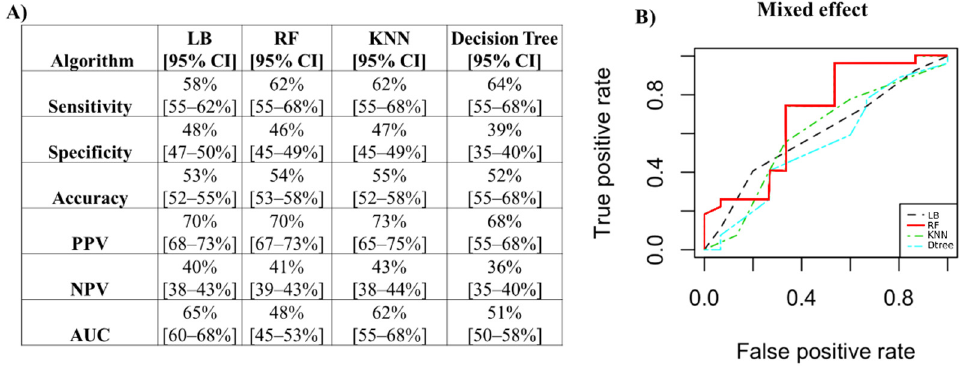
Figure 10. Comparison of each classifier (LB: LogitBoost, RF: Random Forest, KNN: k-nearest neigh- bors, ctree: decision tree) for each batch removal method used to classify patients with positive bi- opsies. ( A ) Boxplot of accuracy values. ( B ) Boxplot of AUC values.